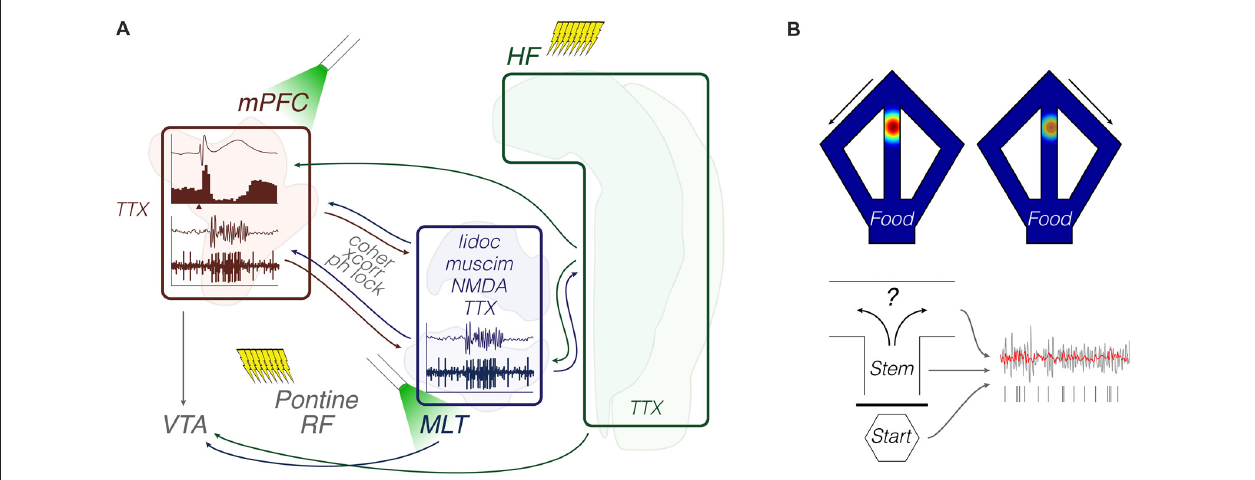
FIGURE 4 | Functional coupling: methods and objects of study merged into a schematic summary. The figure portrays generic representations of techniques reviewed in the “Functional coupling” subsection. Arrows from the HF are generically positioned, i.e., no distinction is made between dorsal, intermediate and ventral domains. Outlines of brain areas are based on Figure 1 . (A) In vivo electrophysiology, intracerebral electrical/optical perturbation and pharmacological manipulations. Experiments evaluated response evoking and circuit connectivity through intra-cerebral drugs and afferent stimulation, including optogenetic terminal inhibition. Lightning icons represent trains of pulses. The beam icon represents intracerebral green light pulses for activation of archaerhodopsins, including on presynaptic terminals. Representative prefrontal cortical data: field potential response with corresponding perievent firing histogram (top; x -axis arrowhead representing afferent stimuli), and theta-filtered voltage trace with corresponding multi-unit activity (bottom; e.g., Hartung et al., 2016; Padilla-Coreano et al., 2016; Bueno-Junior et al., 2018). The latter is also illustrated in the MLT. (B) Chronic electrophysiology and representative activity patterns during maze performance. Top: place-cell and trajectory-dependent firing. Bottom: illustrative single-unit entrainment to raw (gray) and filtered (red) field oscillations depending on the maze location or trial phase (e.g., Ito et al., 2015; Hallock et al., 2016; Bolkan et al., 2017). Abbreviations: coher, coherence; HF, hippocampal formation; lidoc, lidocaine; mPFC, medial prefrontal cortex; MLT, midline/paramidline thalamus; muscim, muscimol; ph lock, phase locking; RF, reticular formation; TTX, tetrodotoxin; VTA, ventral tegmental area; xcorr,